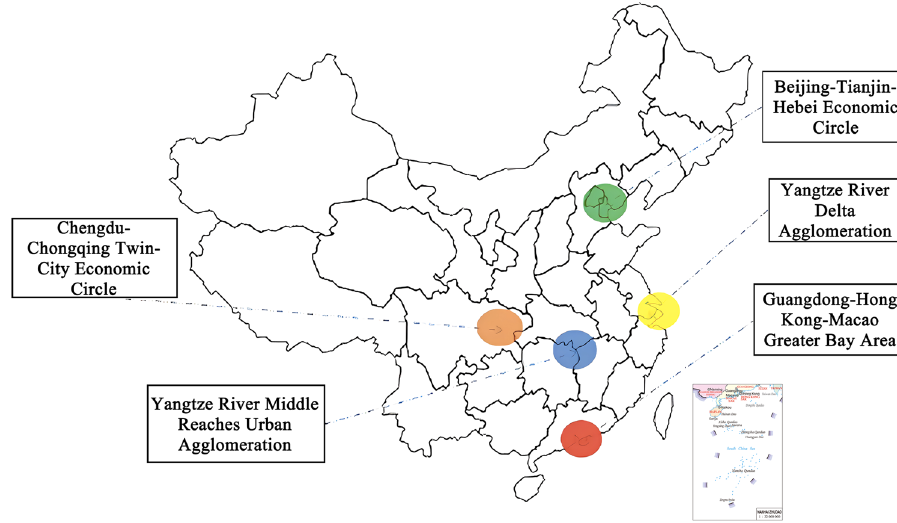
Fig. 2 Four coordinated development areas and the GBA in China. Map based on Ministry of Nature Resources